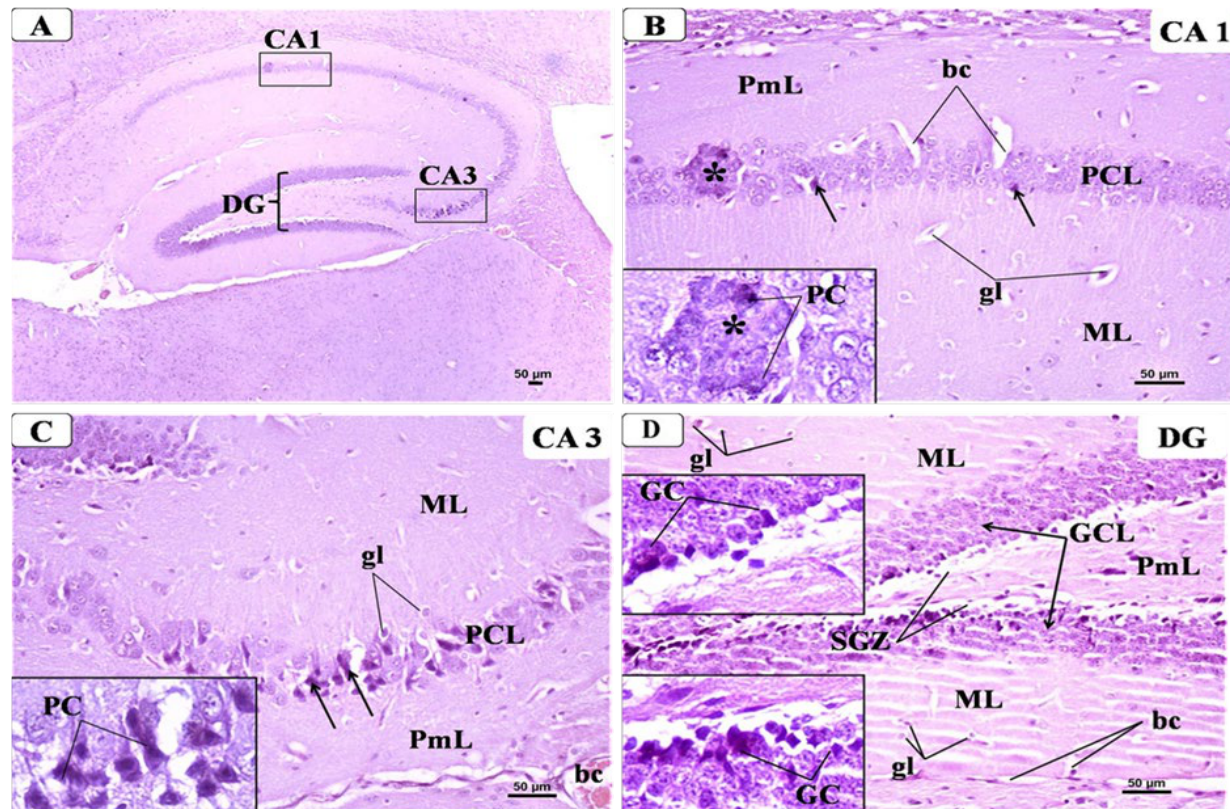
Figure 8. Representative photomicrographs of H&E-stained brain sections showing the hippocam- pus from the CPZ group: ( A ) C-shaped Cornu Ammonis with its CA1 and CA3 areas and dentate gyrus (DG). (H&E × 40). ( B ) CA1 was formed of three layers: molecular layer (M), pyramidal cell layer (PCL), and polymorphic layer (PmL). There was disarrangement of PCL with some pyramidal cells (PC) appeared shrunken which lost their shape and appeared with dark cytoplasm and small condensed nuclei (arrow). Lower inset showed coalesced and hyalinized PCs. (H&E × 200, Inset × 400.) ( C ) CA3 was formed of three layers; molecular layer (ML), pyramidal cell layer (PCL) and polymorphic layer (PmL). There was disorganization and degenerated pyramidal cells (PC). Lower inset showed PCs with dark cytoplasm and condensed nucleus. (H&E × 200, Inset × 400.) ( D ) DG of the CPZ group showing many degenerated granular cells (GC) with vacuolated cytoplasm and condensed nucleus (insets). Notice the dilated capillaries (bc) and increased glial cells (gl) in ML and PmL layer. Widening of SGZ with few small neurons could be